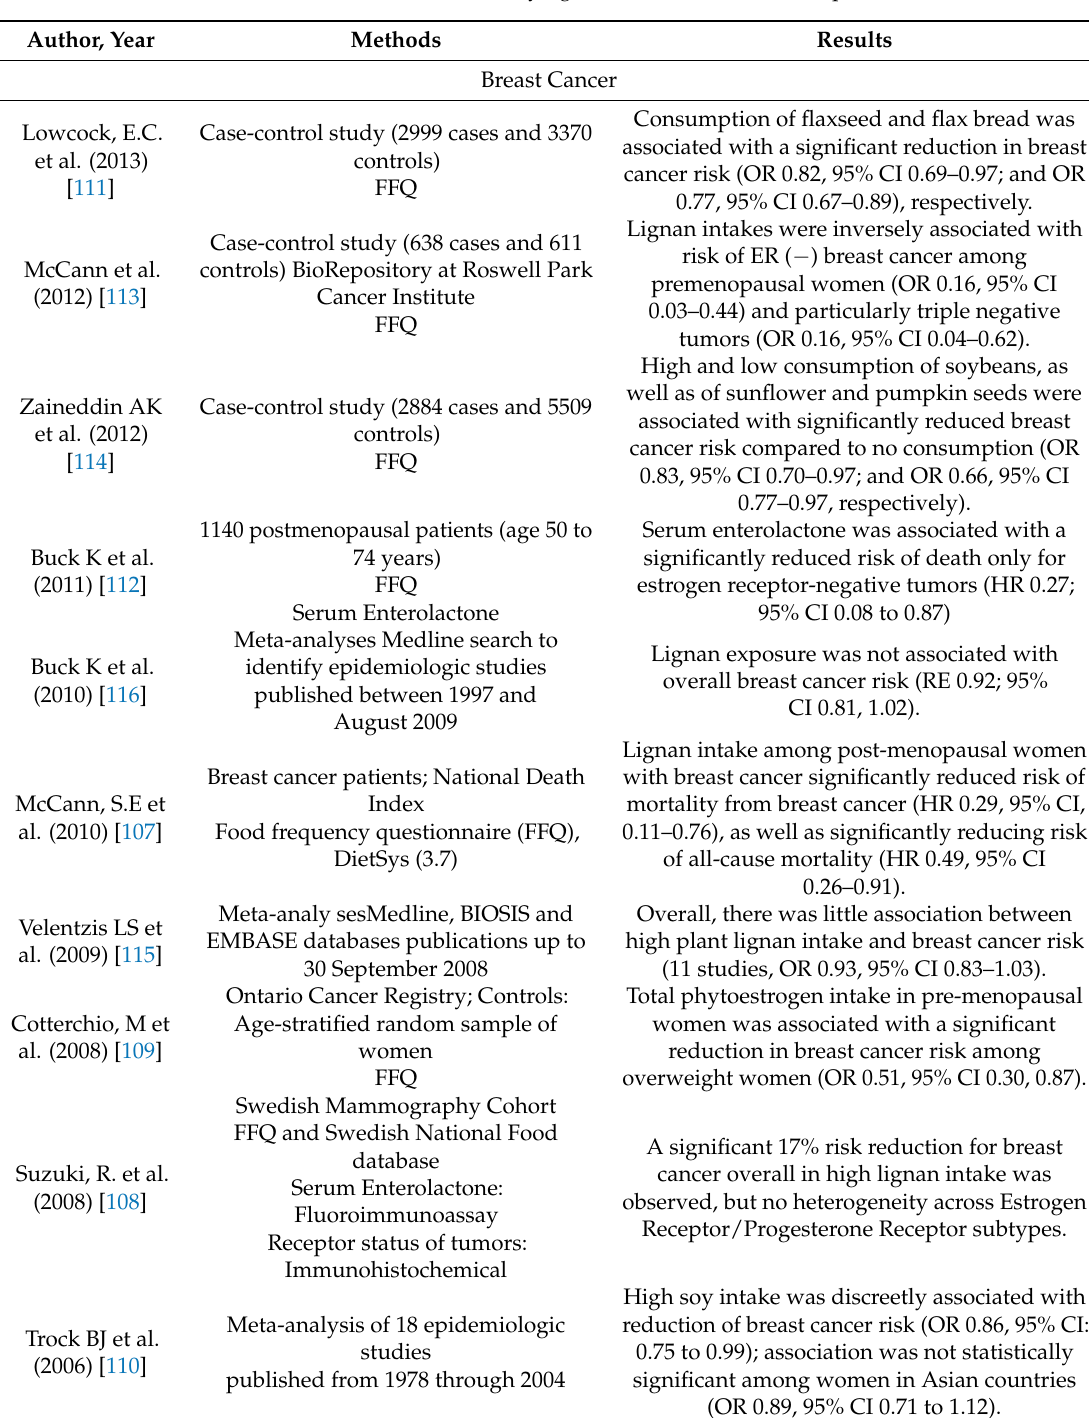
Table 9. Association between naturally lignan-rich foods and health